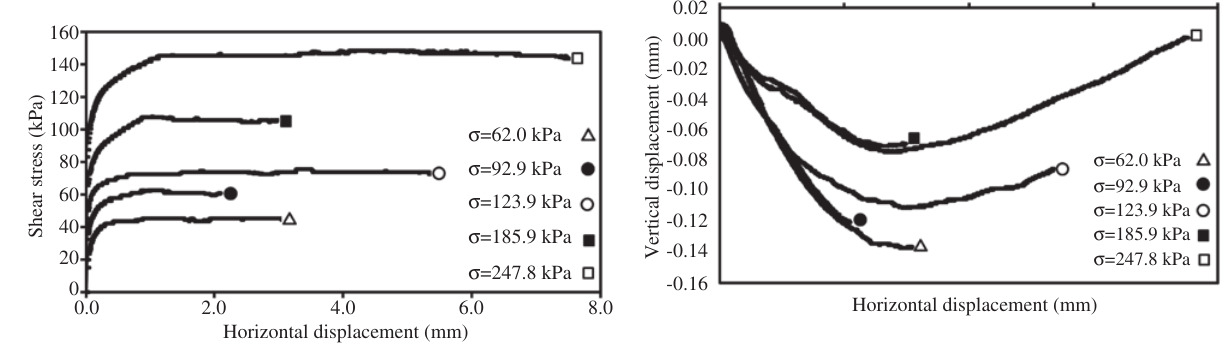
Figure 6 Change in thickness versus horizontal displacement, = 6% (E). l